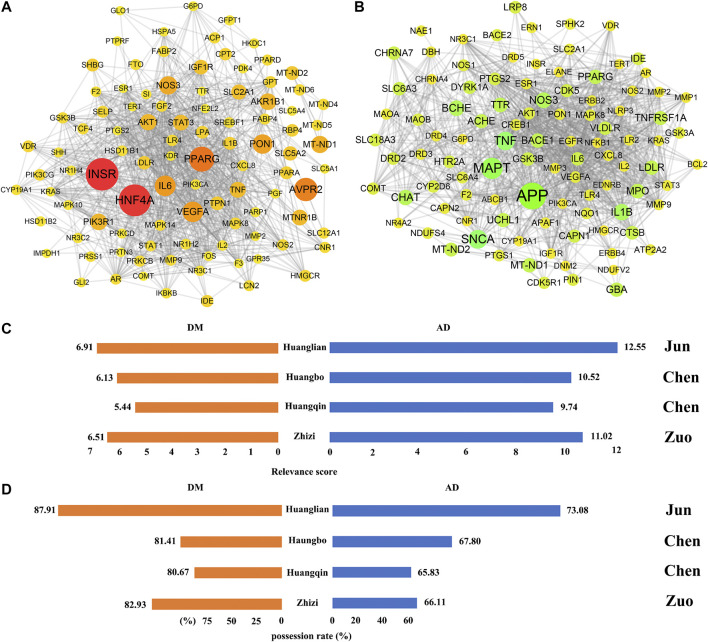
The disease weight gene regulatory network of diabetes mellitus (A) and alzheimer’s disease (B). The size and color of the node represents the relevance score of herbal therapeutic targets. The bar chart represents the average relevance score (C) and possession rate (D) of overlap of botanical drug targets and pathogenic genes.